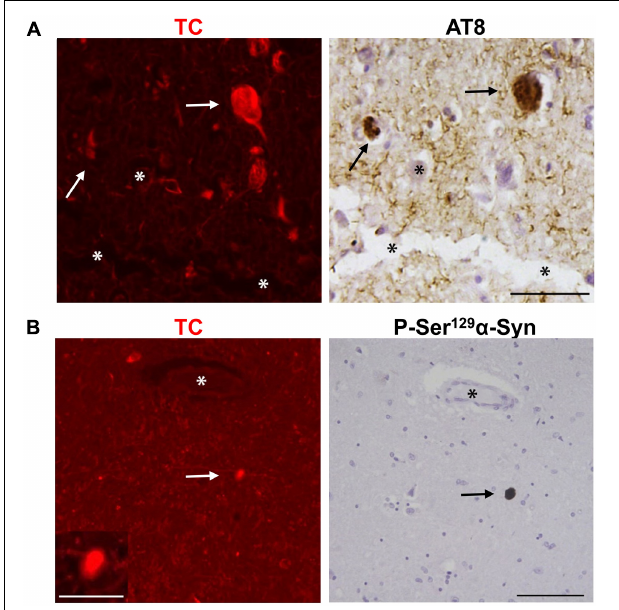
FIGURE 2 | Neuropathological staining of tau aggregates and Lewy bodies (LBs) using the fluorescent probe TC. (A) TC (50 µ M) intensely stained tau aggregates in human AD temporal cortex sections. TC showed staining of tau aggregates in the form of NFTs (arrows) which was confirmed by immunohistochemical staining of the mirror image sections with an antibody, AT8, against phosphorylated tau (P-Ser 202 /Thr 205 tau). (B) TC (50 µ M) intensely stained α -syn aggregates in LBD midbrain sections. TC stained α -syn aggregates in the form of LBs (arrows), which was confirmed by immunohistochemical staining of the mirror image sections with an antibody against phosphorylated α -syn (P-Ser 129 α -syn). The images of the dyes-staining were flipped horizontally to match the same location of the immunohistochemically-probed sections. The asterisks in both sections correspond to the same structures. Scale bar 50 µ m. Inset scale bar 10 µ